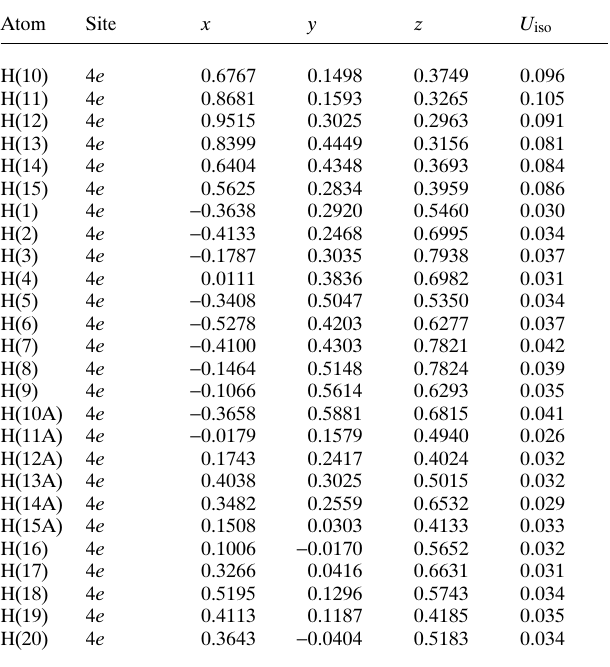
Table 2. Atomic coordinates and displacement parameters (in Å 2 )